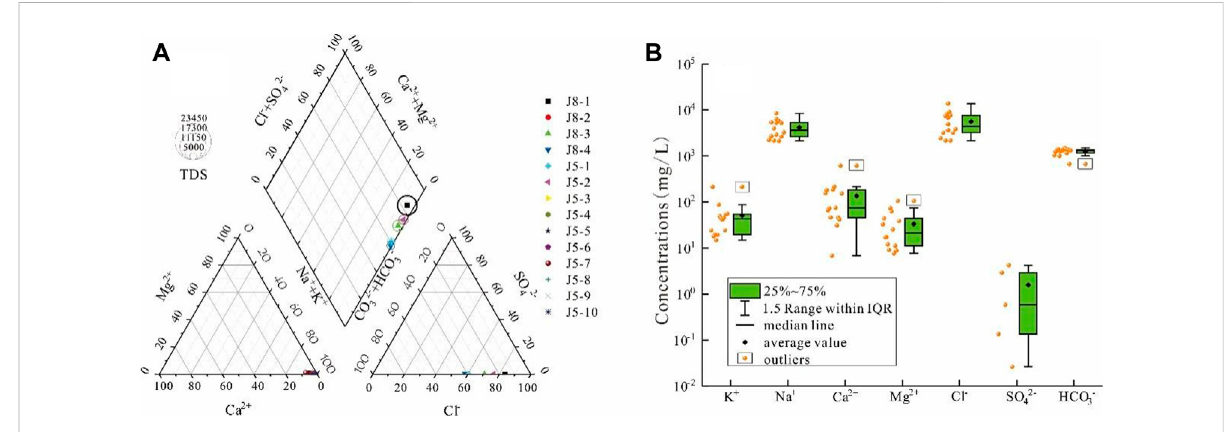
FIGURE 1 Piper diagram [ (A) ; Bao et al., 2021 and box chart of ion concentrations (B) ; Guo et al., 2017] of coalbed-produced waters in the Linfen mining area.